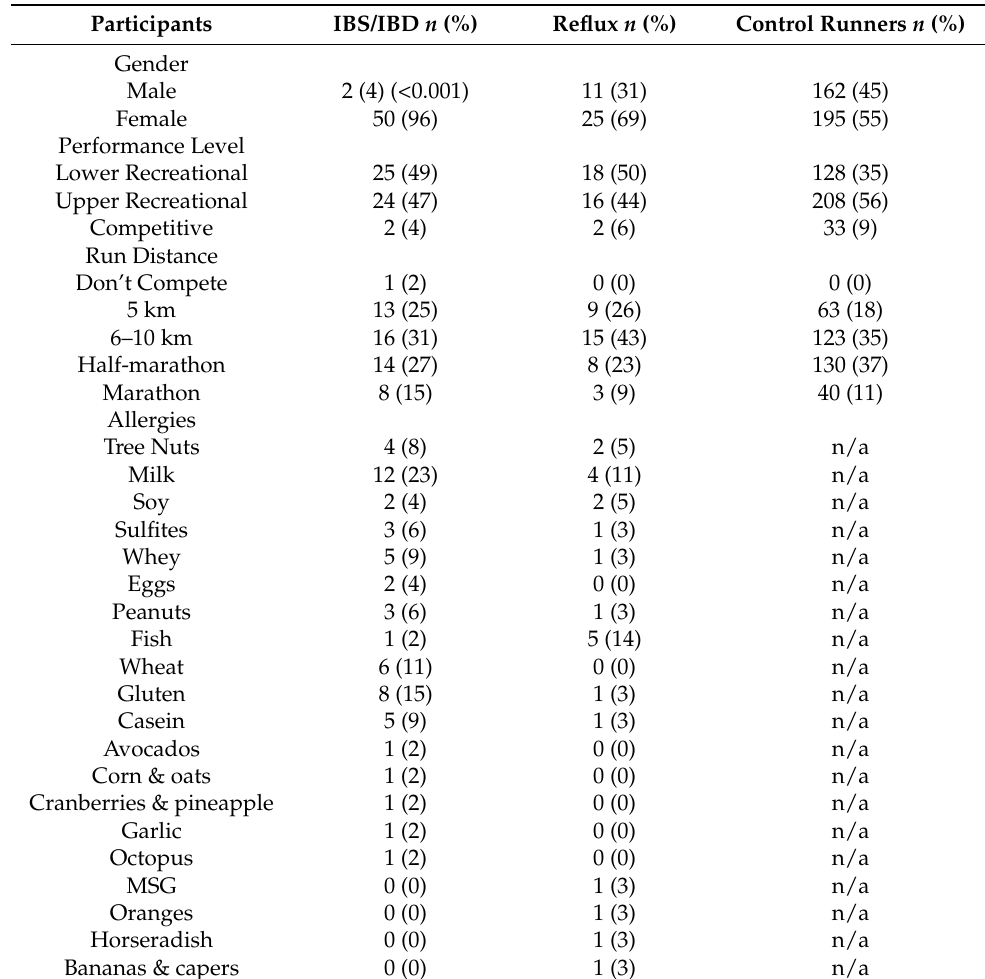
Table 1. Participant